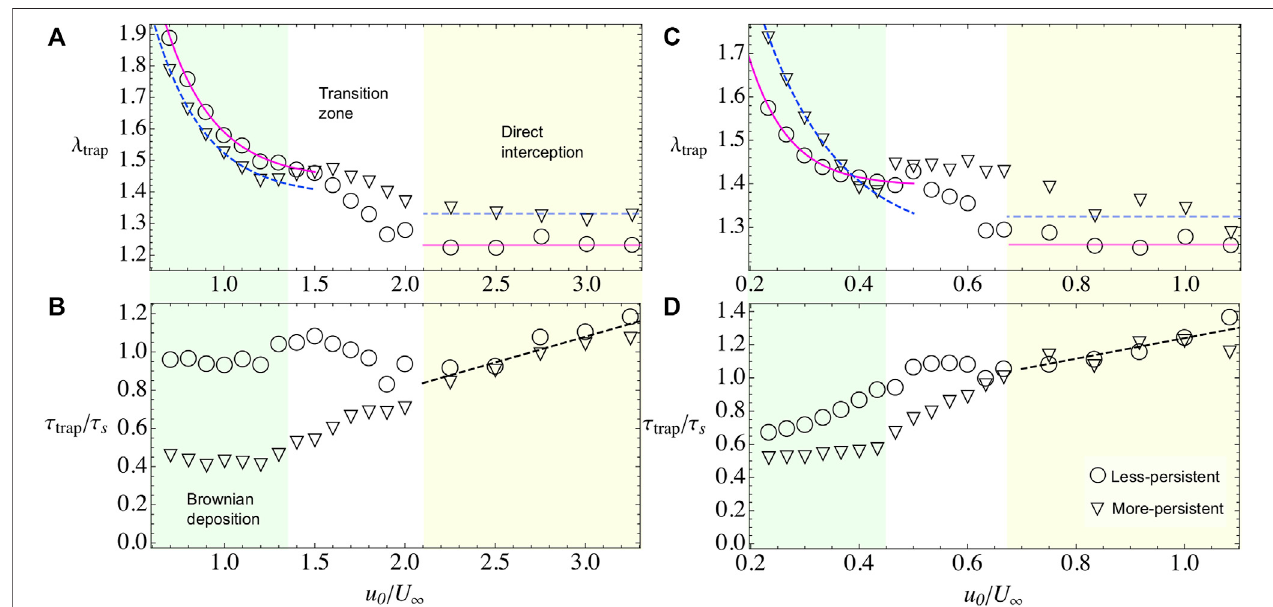
FIGURE4| Bacterialadhesionobservableswhenvaryingthemicroswimmer ’ sactivity u 0 andwhentheexternal fl ow fi eldis U ∞ =20 (A,B) andwhenis U ∞ =60 (C,D) . Inbothcases,wespanthetworegimesbyshadingtheareaandlettingthetransitionzoneinwhite.Less-persistentmicroswimmer ’ sresultsareshownwithtrianglesand more-persistent microswimmers in circles. (A,C) λ trap for less- and more-persistent microswimmers, respectively. The solid and dashed lines, during Brownian deposition, are phenomenological fi ts with the law λ trap = A (1+ B exp( − ( u 0 / U ∞ ) C )). The blurry lines represent a guide to the eye, for the tendency during the direct interception regime. (B,D) τ trap for less- and more-persistent microswimmers, respectively. During the Brownian deposition, more-persistent microswimmers reach the steady state faster than the less-persistent microswimmers, being more dramatic the difference for the weak external fl ow case U ∞ =20, where τ trap / τ s ~1 showing that the steady state is reached when microswimmers travel half of the obstacle perimeter. Meanwhile, during the direct interception regime, both curves collapsed and are phenomenological described by a linear fi t τ trap / τ s = A (1+( u 0 / U ∞ )).